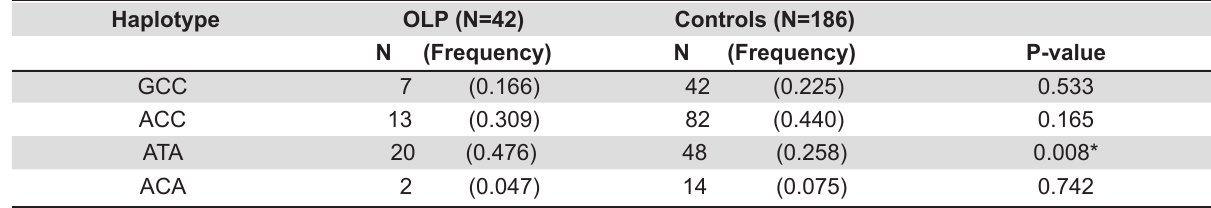
Table 3- Haplotype analysis of IL-10 -1082G/A, -819T/C and -592C/A polymorphisms in OLP and control groups